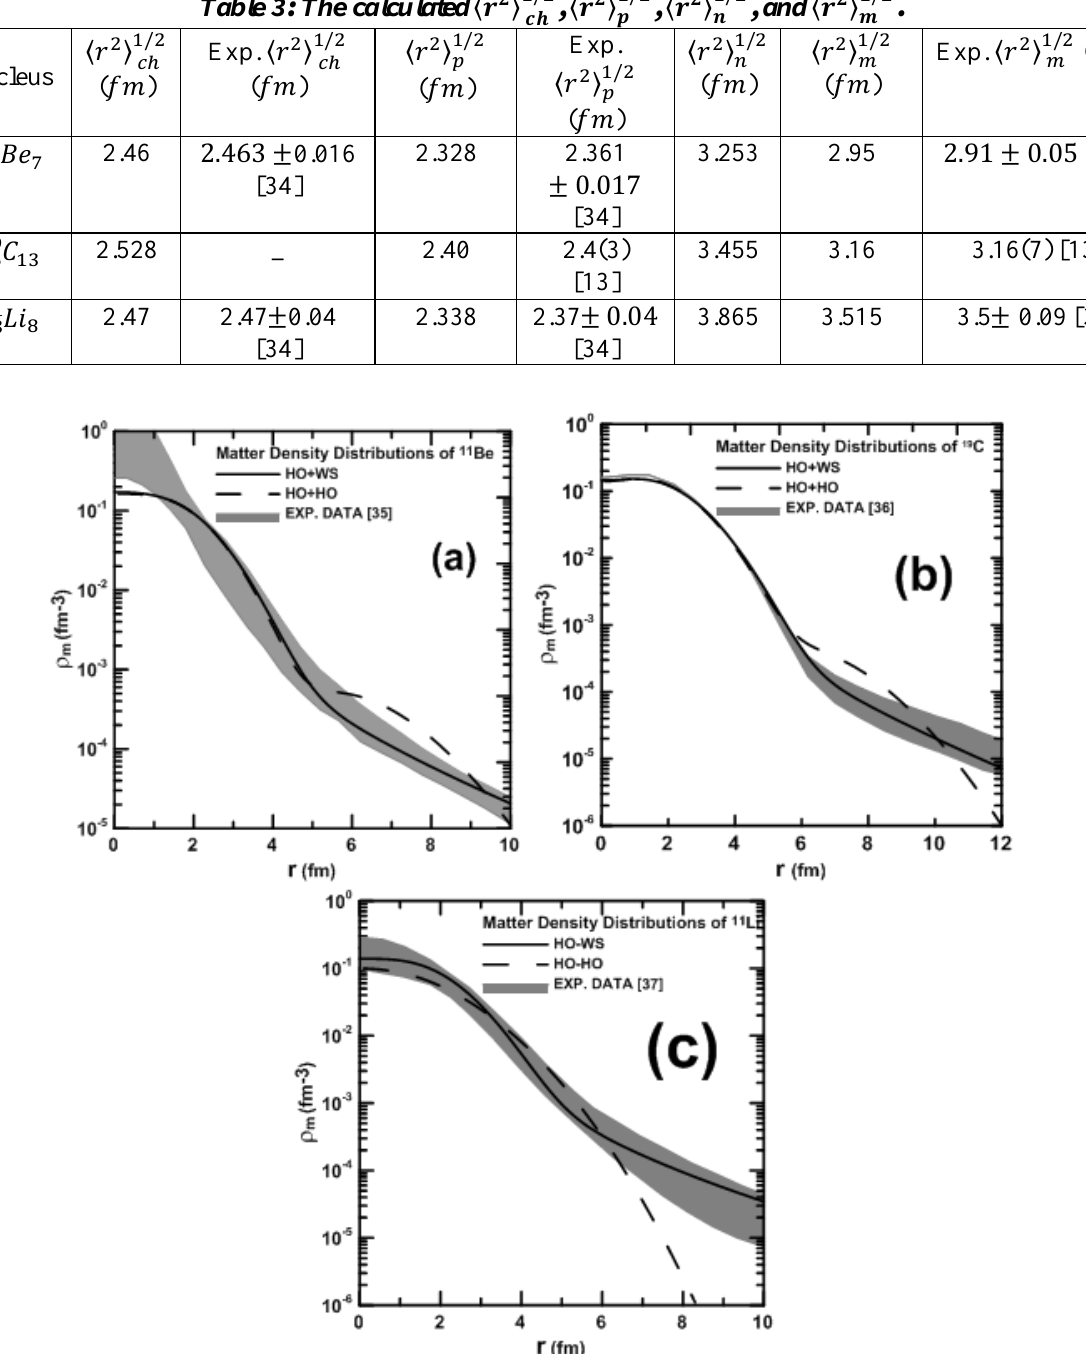
Fig. 1: The calculated matter density distributions for 11 Be, 19 C and 11